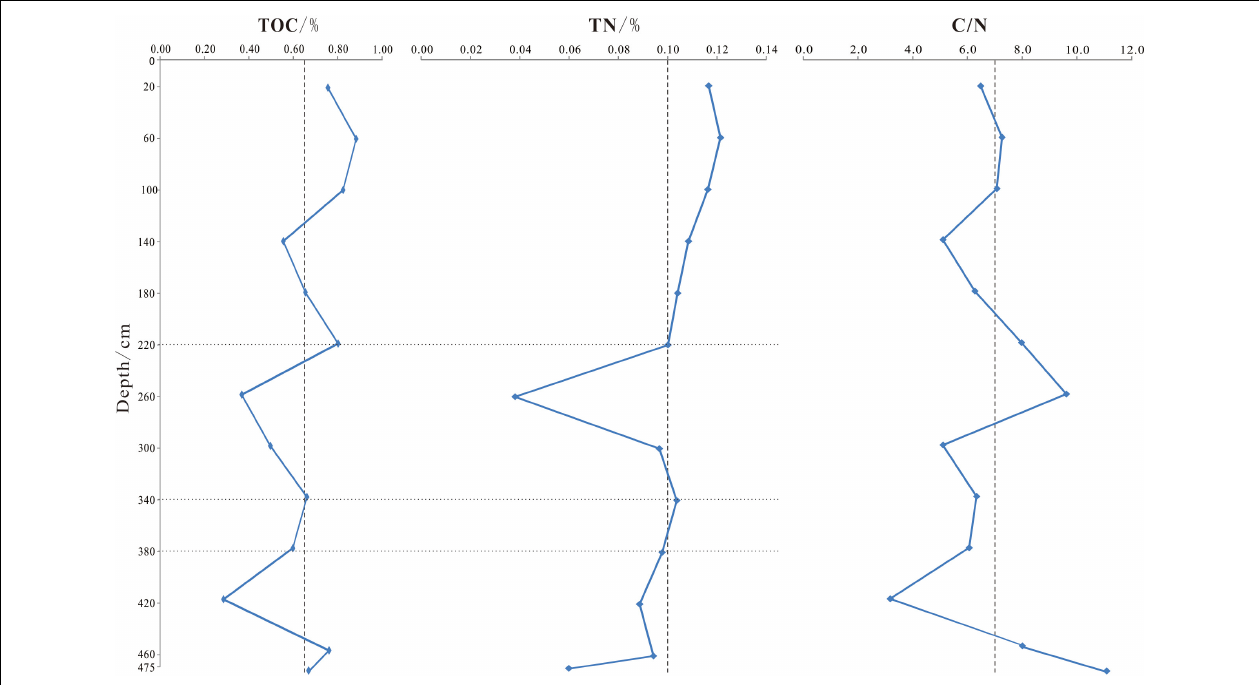
FIGURE 2 | Vertical profiles of TOC, TN, and CN in core sediment A.